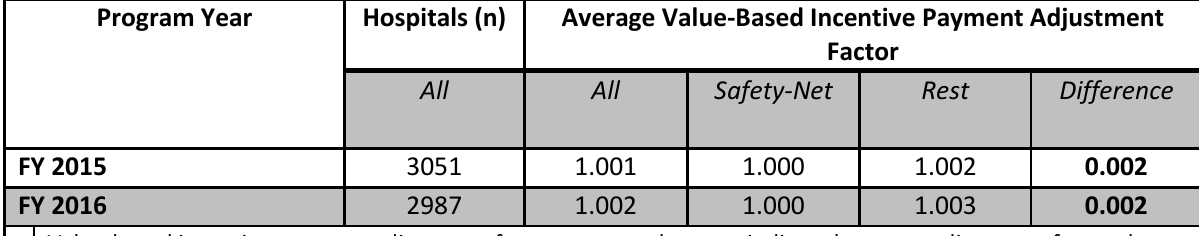
Table 7.10. FY15 and FY16 HVBP Payment Impacts: Average Value-Based Incentive Payment Adjustment Factor, by Hospital Safety-Net Status (top 20%